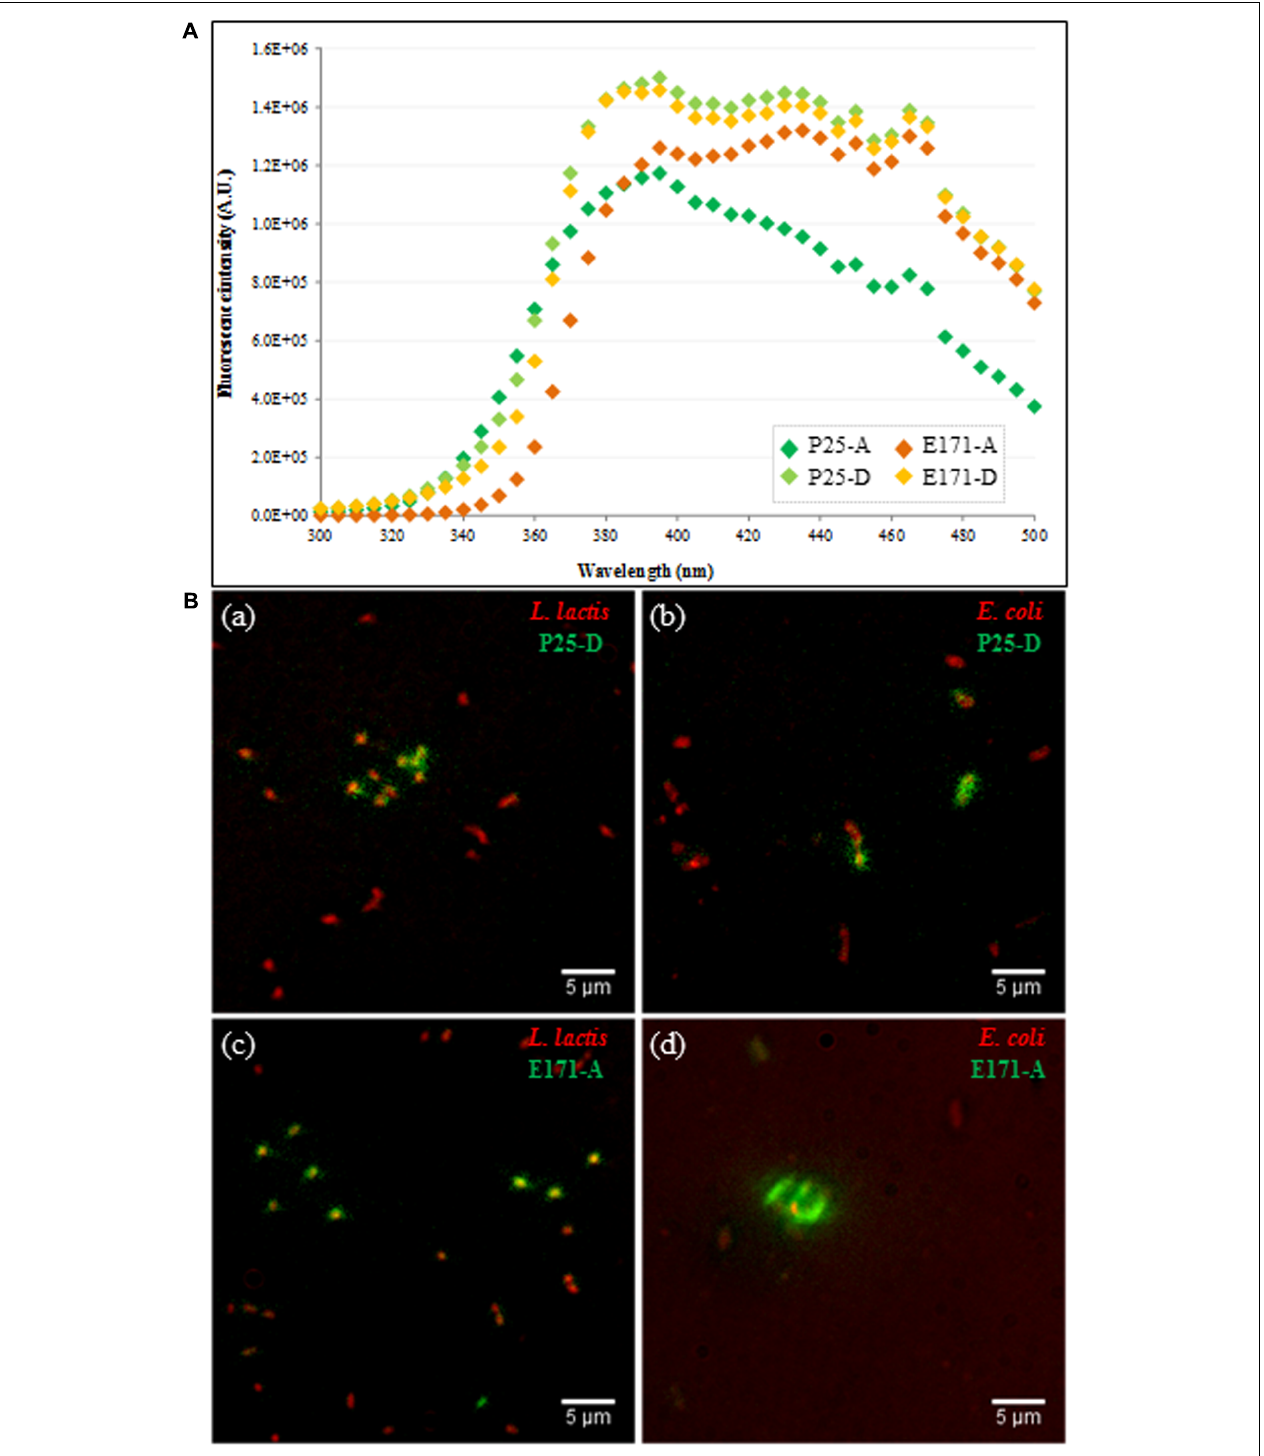
FIGURE 1 | Synchrotron excitation deep ultraviolet (DUV) fluorescence imaging of bacterial cells after Titanium dioxide (TiO 2 ) exposure. (A) Fluorescence emission spectra ( λ exc = 270 nm) of TiO 2 320 µ g/mL food-grade E171 (in orange) vs. TiO 2 -NPs P25 (in green) in aggregated (dark color) and dispersed (light color) forms; (B) Overlaid fluorescence images of (a,c) growing Lactococcus lactis IBB477 cells and (b,d) growing Escherichia coli K12 MG1655 cells (in red) exposed to (a,b) P25-D and (c,d) E171-A (in green) at 320 µ g/mL. Yellow color indicates TiO 2 particles that are co-localized with bacteria. Scale bar corresponds to 5 µ